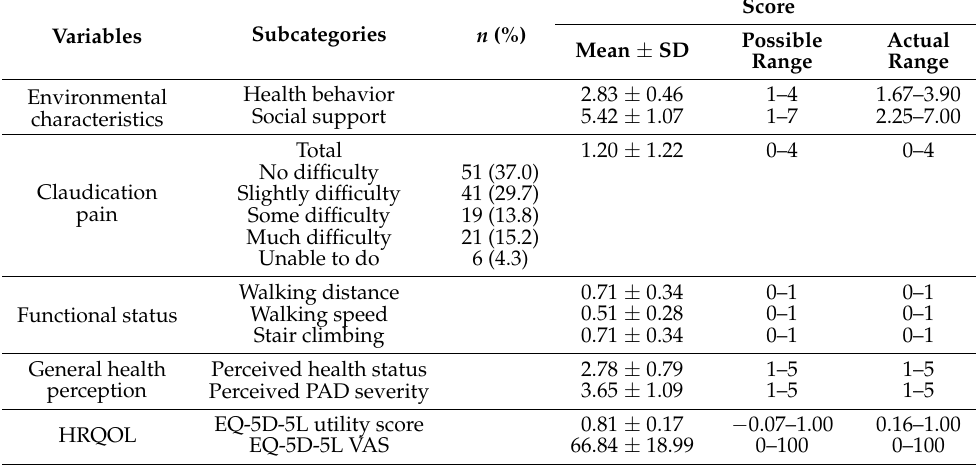
Table 2. Associated factors with HRQOL in the theoretical model ( n = 138).